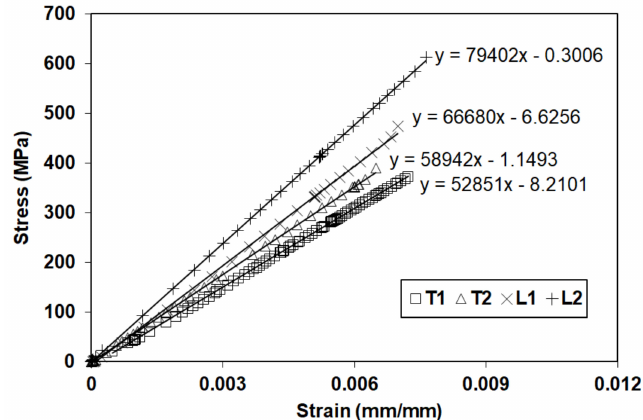
Figure 3. Stress-strain curves of CFRP grid stands obtained from axial tensile tests with linear regression lines and the equations of these lines used to determine modulus values (slope of each line) [3].